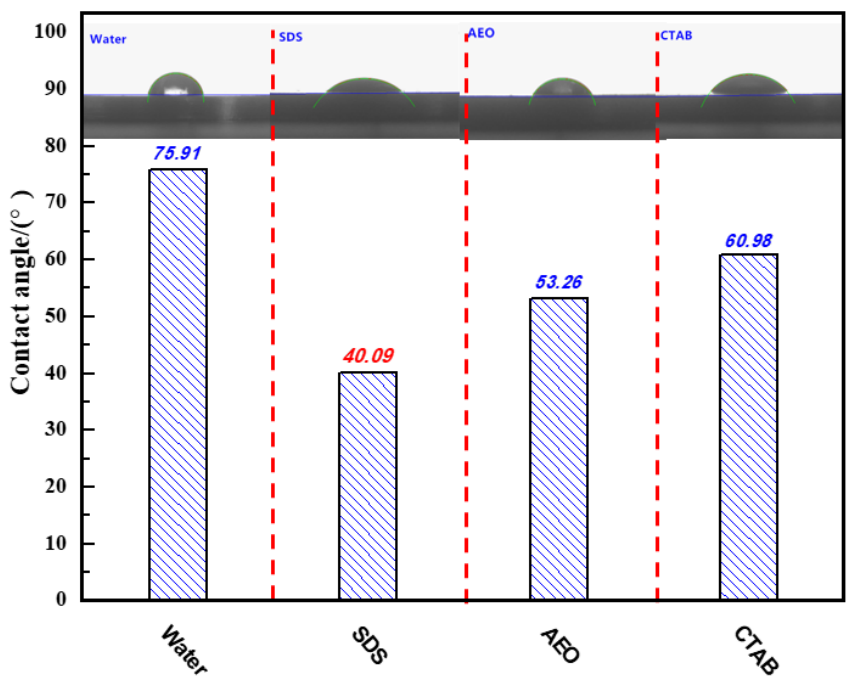
Figure 6. Contact angles of different surfactants on coal samples.